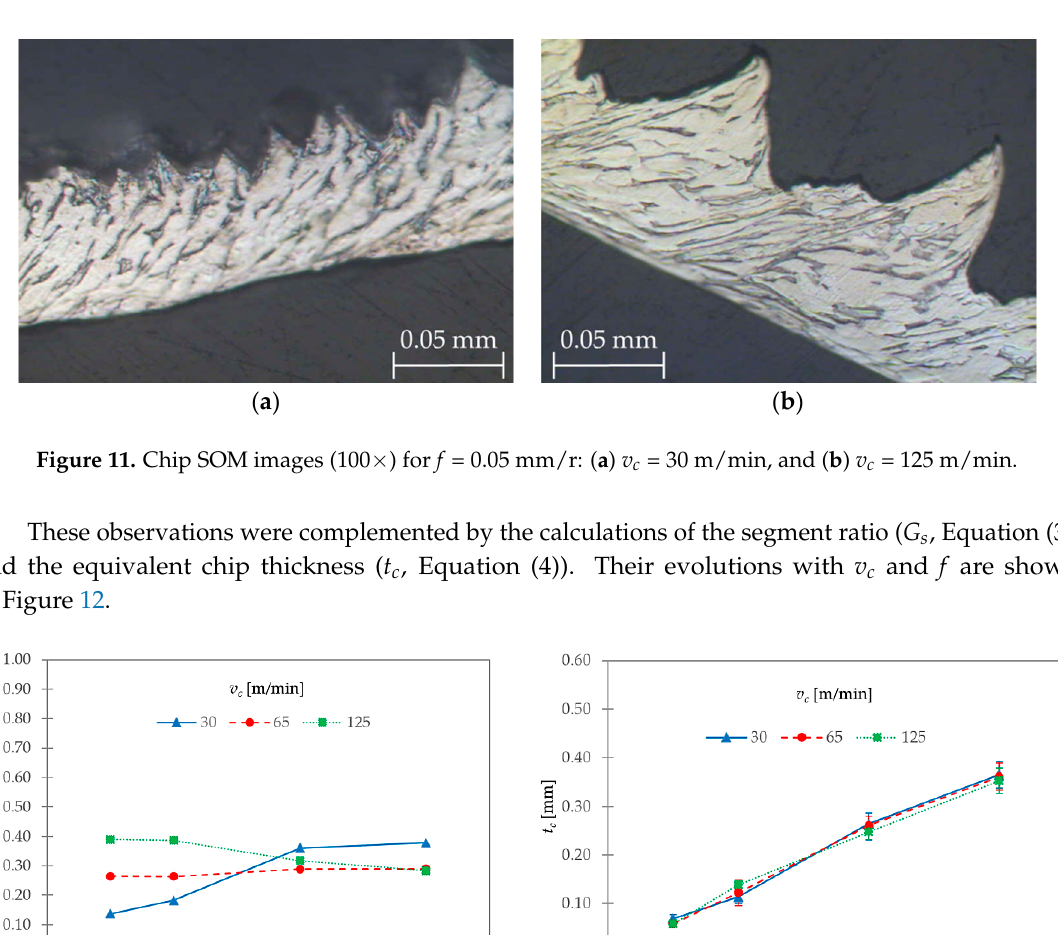
Figure 10. ( a ) Heights of peaks ( h p ) and ( b ) valleys ( h v ) as a function of v c and f .